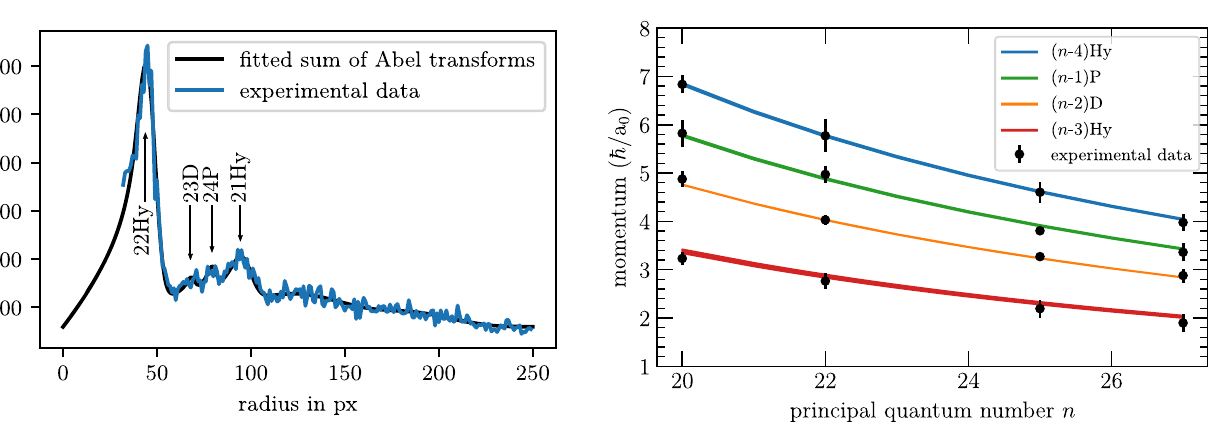
Fig. 5 Angular integrated radial pro fi le of the momentum distribution shown in Fig. 3. The integration is performed over a circle segment, where the spectrum shows the least distortion. The center peak is omitted due to scaling purposes. Four peaks are visible. The two most pronounced peaks correspond to manifolds 22Hy and 21Hy. In between, the 23D- and 24P- states are visible. We do not see signatures of a decay to the 25S-state, which should appear between 22Hy and 23D. For higher radii, only the envelopes of the peaks are visible.